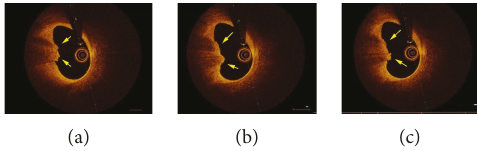
Figure 2: Representative OCT images of the culprit lesion. (a, b, c) Plaque erosion: adjacent thrombus (yellow arrows) overlying an intact fi brous